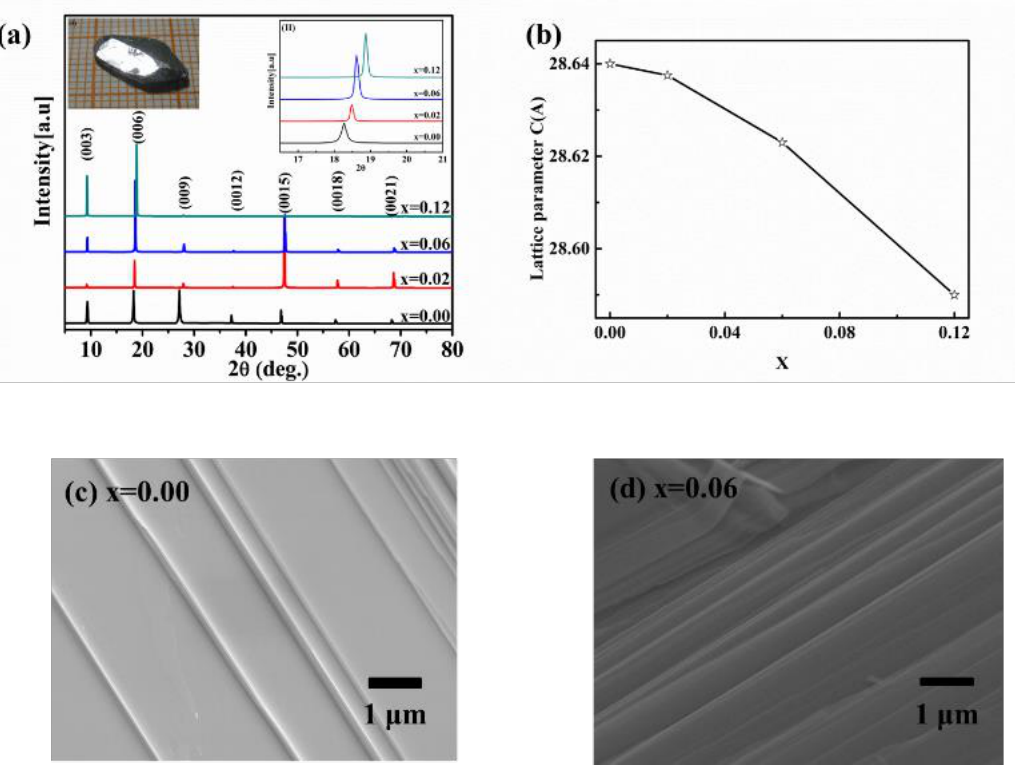
Figure 2. With different Co concentrations: ( a ) the XRD patterns of Co x Bi 2- x Se 3 ; ( b ) the decreasing lattice constant c amount (the stars represent the lattice parameters of c in the (006) direction with the different Co doping concentrations); ( c ) the typical FESEM images of the Co x Bi 2- x Se 3 crystals with x =0.00; and (d) x = 0.06.